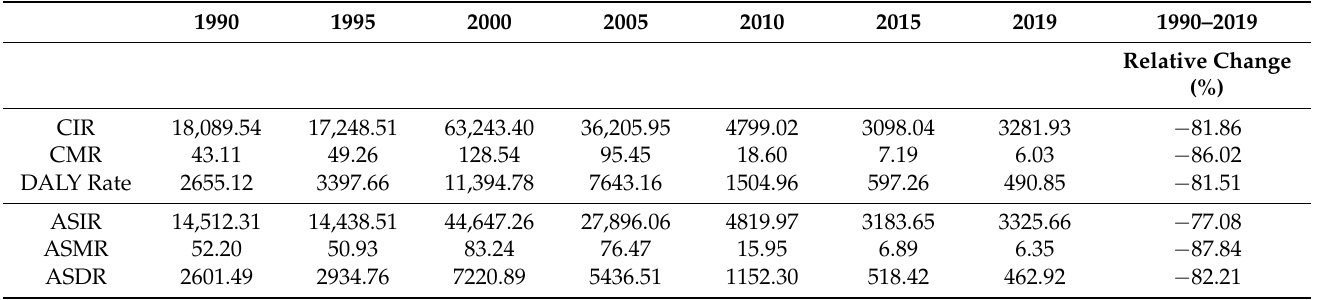
Table 1. Trends of the crude rate and age-standardized rate per 100,000 for malaria among Sao Tome and Principe males and females in the period from